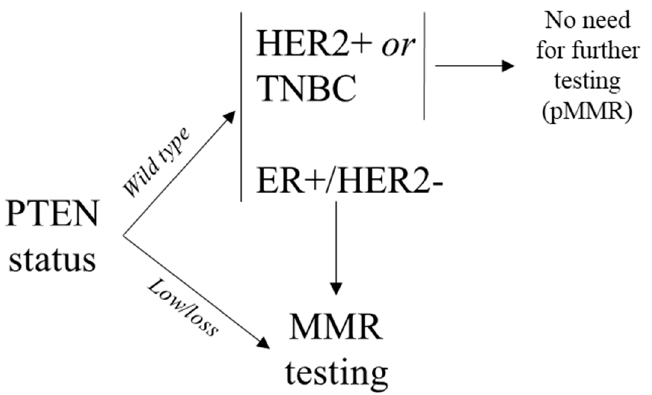
Figure 3. Diagnostic algorithm for the evaluation of mismatch repair status in breast cancer using PTEN immunohistochemistry as a complementary test. In this proposed workflow, PTEN can be profiled before the execution of other tests in order to pre-screen patients for MMR proficiency. Tumors showing HER2 overexpression and / or amplification and those with a triple-negative phenotype should be considered mismatch repair proficient if PTEN expression is retained, with a positive predictive value of 95% and 100%, respectively. TNBC, triple-negative breast cancer; ER, estrogen receptor; MMR, mismatch repair; pMMR, mismatch repair proficient.